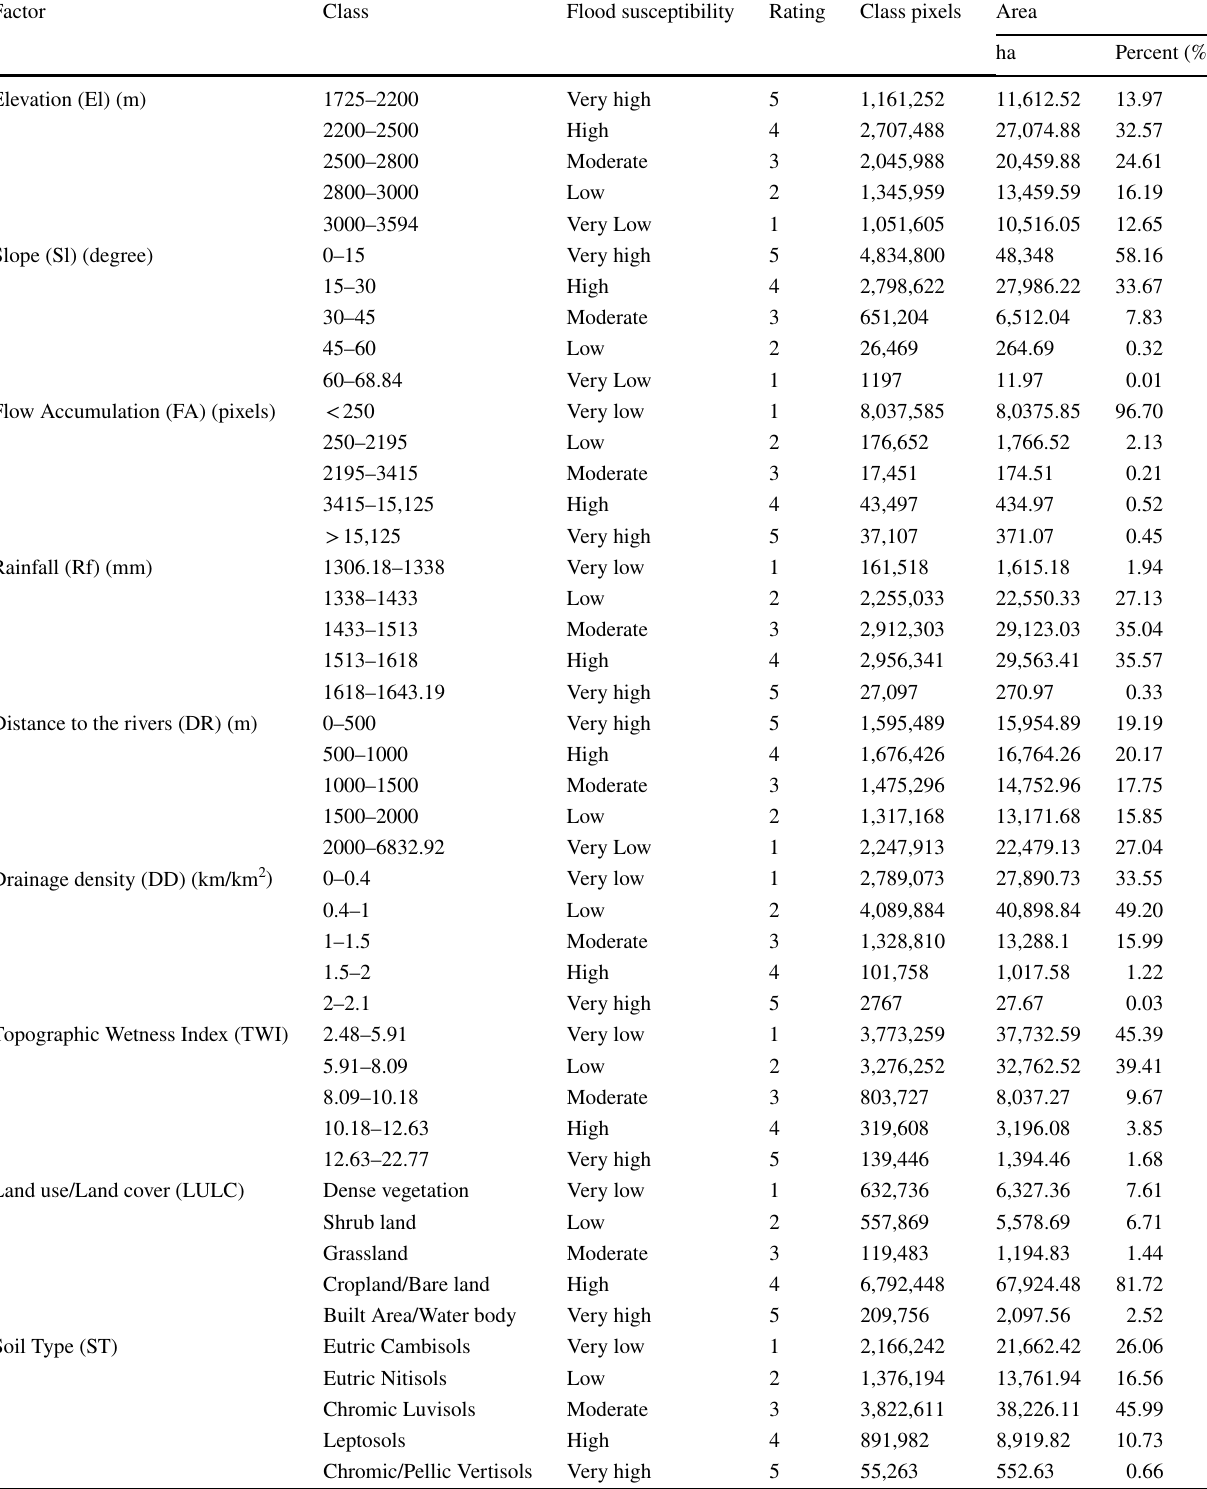
Table 2 Flood conditioning factors, their classes, rating values, area coverage, and percentage